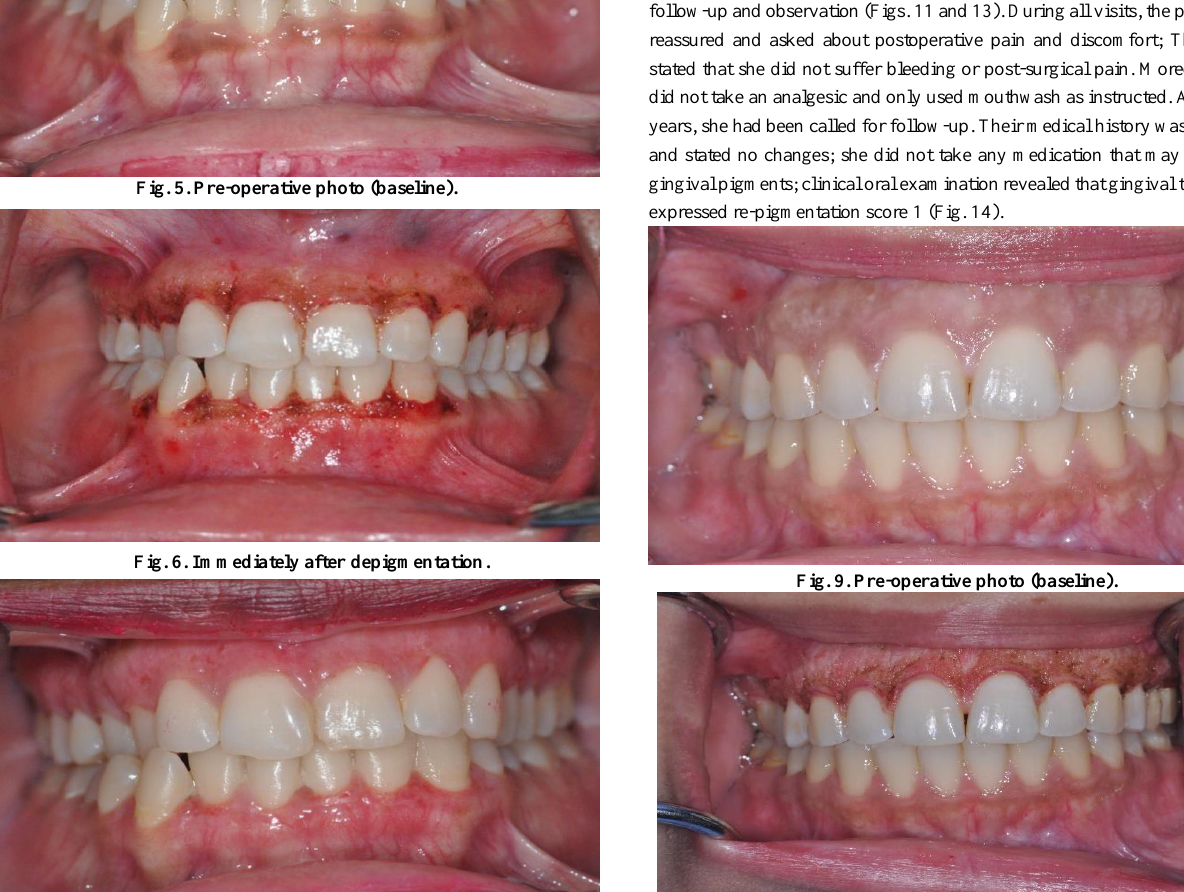
Fig. 10. Upper arch